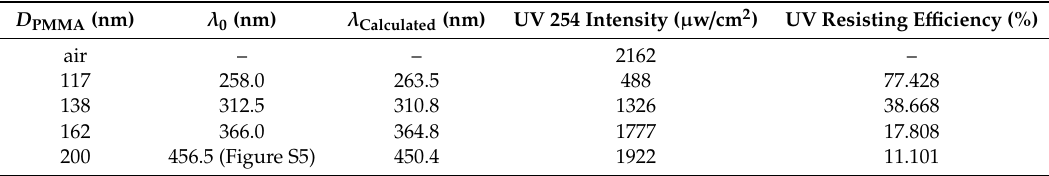
Table 1. UV-254 shielding performance of PMMA photonic crystal diffraction.